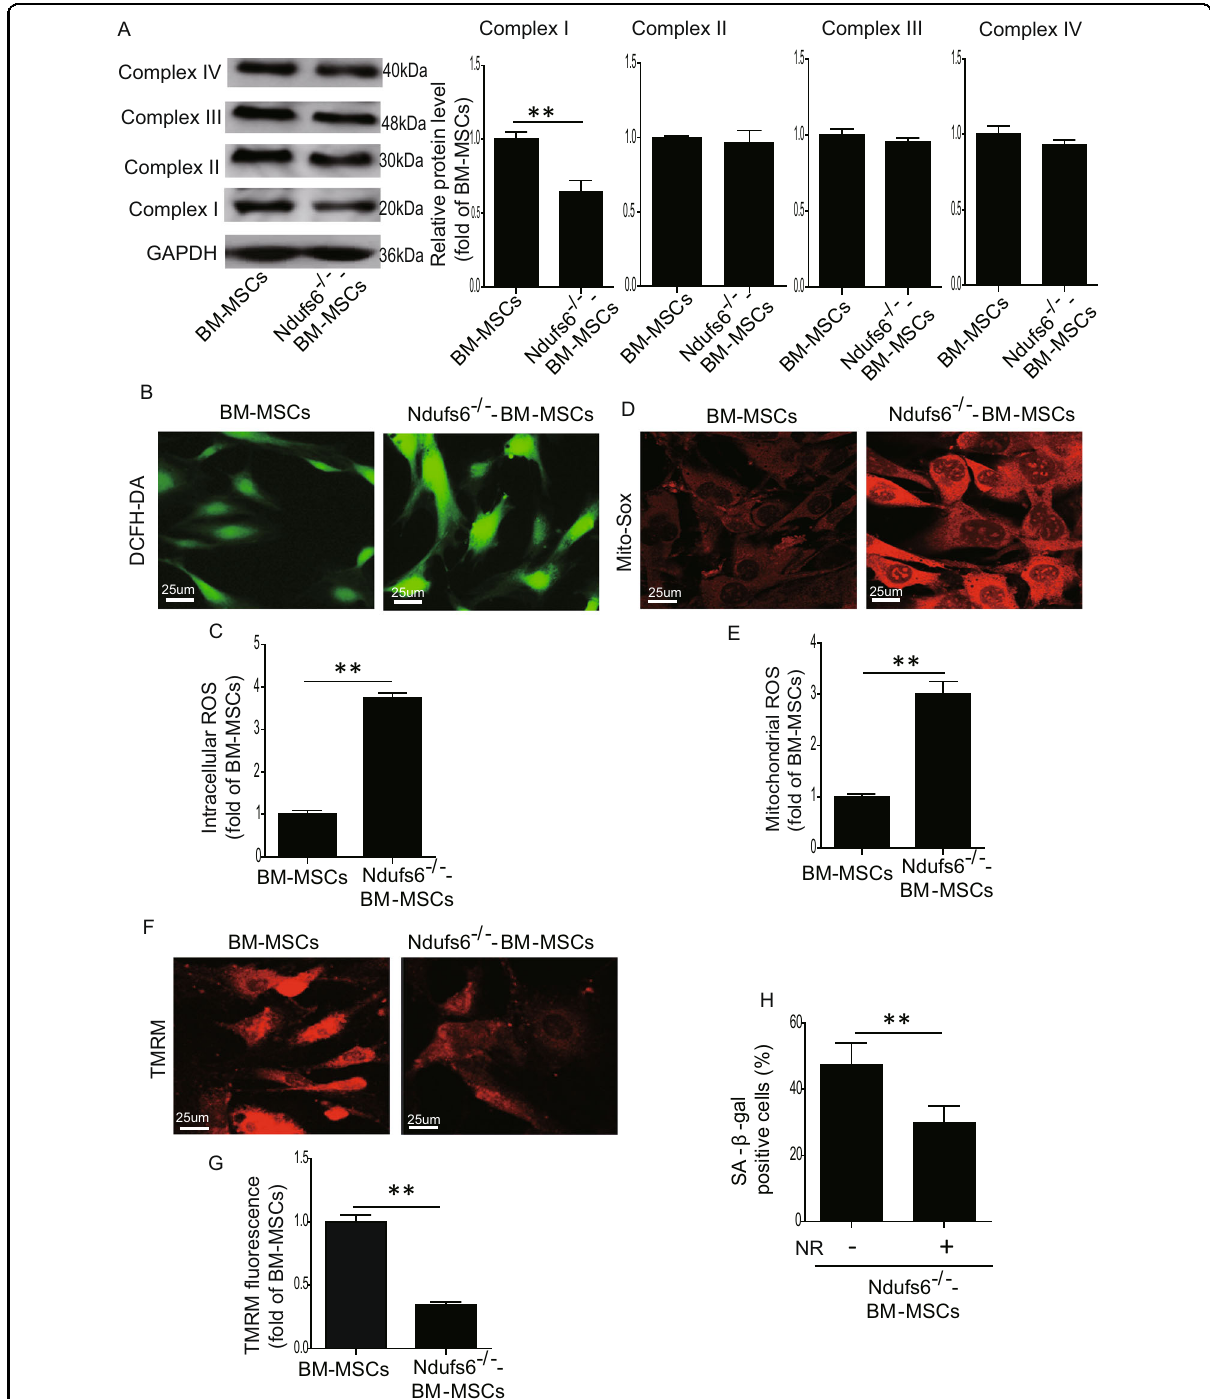
Fig. 5 Ndufs6 − / − -BM-MSCs exhibit complex I de fi ciency and enhanced ROS generation. A The protein level of complexes I, II, III, and IV was evaluated in BM-MSCs and Ndufs6 − / − -BM-MSCs. B The intracellular ROS of BM-MSCs and Ndufs6 − / − -BM-MSCs was measured by DCFH-DA staining. C The intracellular ROS of BM-MSCs and Ndufs6 − / − -BM-MSCs was statistically quanti fi ed. D The mitochondrial ROS of BM-MSCs and Ndufs6 − / −